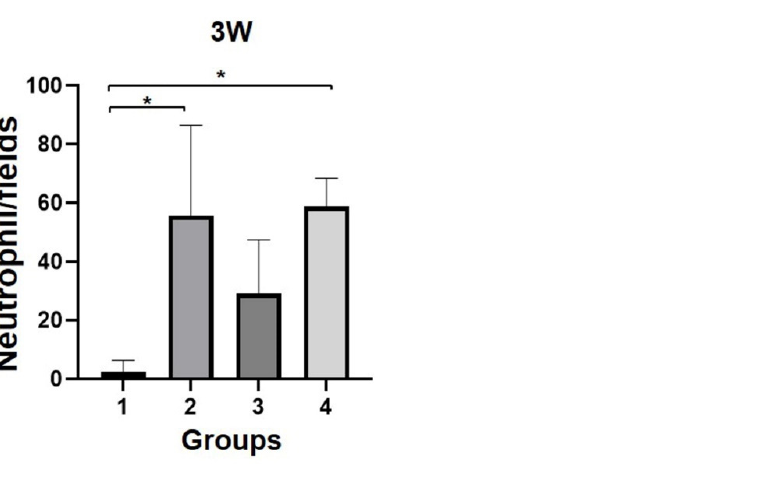
Figure 6. The neutrophils in the corneal stroma were counted at the high-power field. Neutrophils were increased in all groups except group 1, and group 3 showed a lower value than groups 2 and 4. n = 8 in groups 1, 2, and 4; and n = 9 in group 3. *, p ≤ 0.05 .